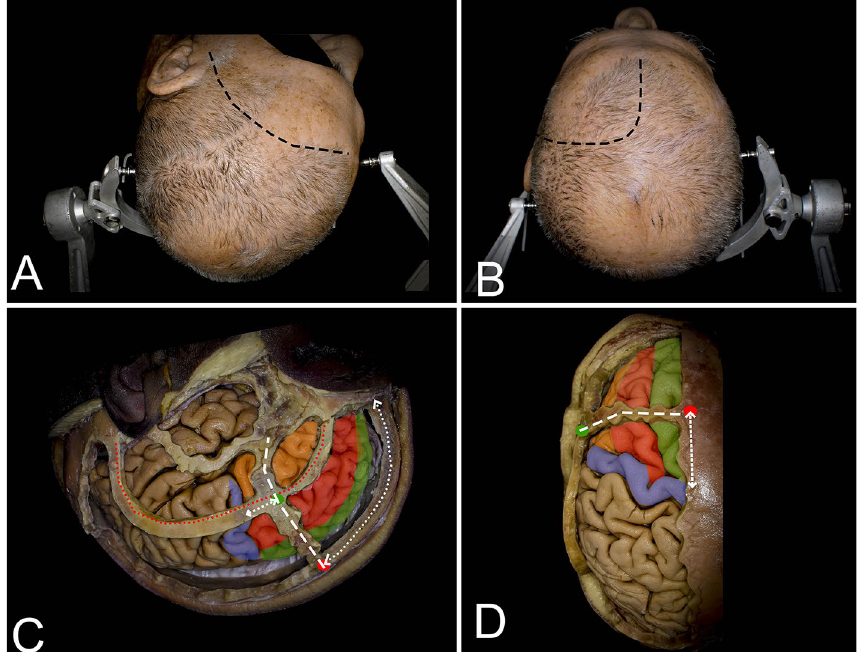
Figure 1. Figure presenting the surgical perspective of the lateral ( A,C ) and superior ( B,D ) approaches to the frontal lobe. ( A ) For the lateral approach, the head is rotated contralateral to the operated side, and a curved skin incision (black dashed line) is made in the frontotemporal region within the hairline, allowing proper exposure of the basal regions of the frontal lobe. ( B ) For the superior approach, the head is positioned in the neutral position, and a curved skin incision (black dashed line) within the hairline is made. c, d. Most of the frontal lobe is identified anterior to the coronal suture (white dashed line). The posterior part of the frontal lobe, including the precentral gyrus (blue), is located behind the coronal suture, and on the midline, the precentral gyrus is located approximately 4.5 cm behind bregma (red dot), while on the lateral surface, the precentral gyrus is located in proximity to the lateral sulcus 2.5 cm behind the stephanion (green dot). The coronal sutures are usually easily palpable through the skin, but in difficult cases, they can be identified approximately 13 cm behind the nasion along the midline (white dotted line) 13,27,35 . The inferior frontal gyrus (orange) is identified below the superior temporal line (red dotted line). The pars opercularis of the IFG is located behind the coronal suture, while the pars triangularis and orbitalis are located anteriorly. The middle (red) and superior frontal gyri (green) are located between the midline and the superior temporal